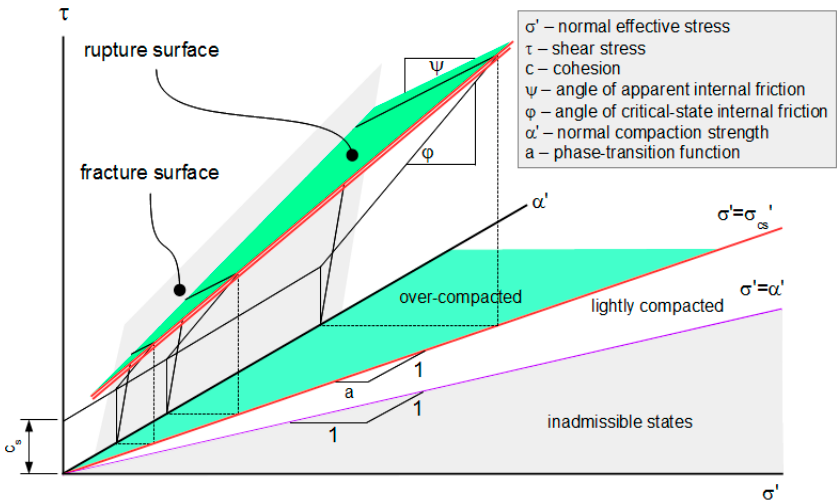
Figure 9. Projection of rupture surface for shearing mode ω = 1/2 and coherence threshold α 0 ’ = 0. 3. Discussion 3.1. Strength The present theory is a bounded theory of rupture strength. Its bounding conditions are fracture and critical flow at high and low stress ratios respectively. Similar to the theories of Coulomb, Terzaghi and Jenike, the present theory is independent of kinematics. Its interlocking strength contributes to shear strength in linear proportion to normal compaction. The coefficient of interlocking strength measures the difference in the orientations of the material’s rupture and slip